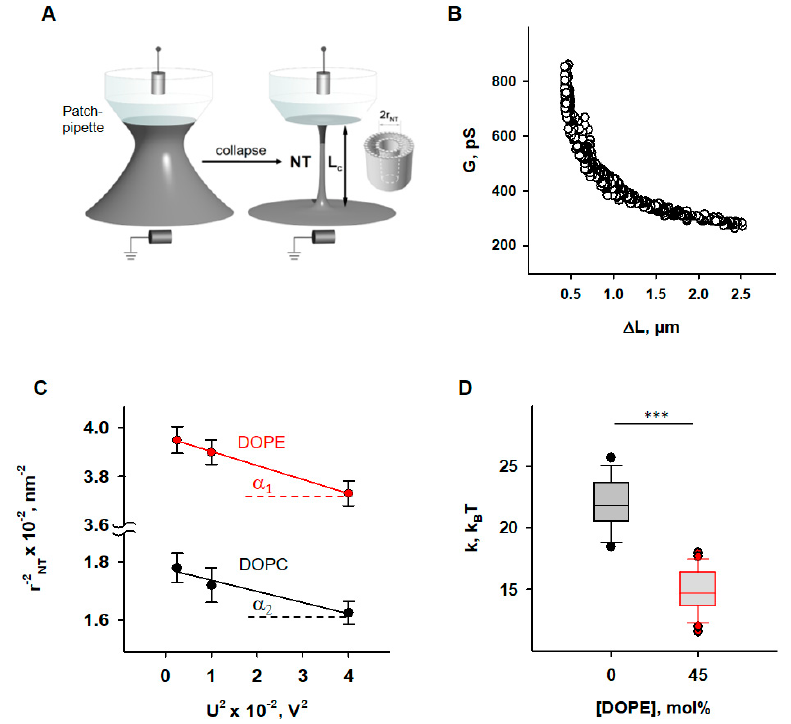
Figure 1. Determination of the elastic parameters of the lipid bilayer membrane based on nanotube ( NT ) pulling. ( A ) Scheme of NT s pulled from a bilayer lipid membrane (grey) and held by a patch-pipette (white). A voltage applied to the ends of the NT s (U) induces an ion current ( I NT ) flowing through the NT interior. ( B ) A representative measurement shows the dependence of measured membrane conductance (G) (black circles) on the NT length change ( Δ L), required for calculation of the NT radius ( r NT ) (see Methods). ( C ) Dependence r NT on U, obtained for the membrane lipid compositions DOPC:CL 90:10 (black) and DOPC:DOPE:CL 45:45:10 (red). ( D ) Box plot and distribution of the bending modulus, k, depending on the molar concentration of the phosphatidylethanolamine (DOPE). The buffer solution contained 100 mM KCl, 10 mM HEPES, and 1 mM EDTA at pH 7.0 and T = 295 K. Data points represent the mean and standard deviation from more than 10 independent experiments. *** p < 0.001, t -test.